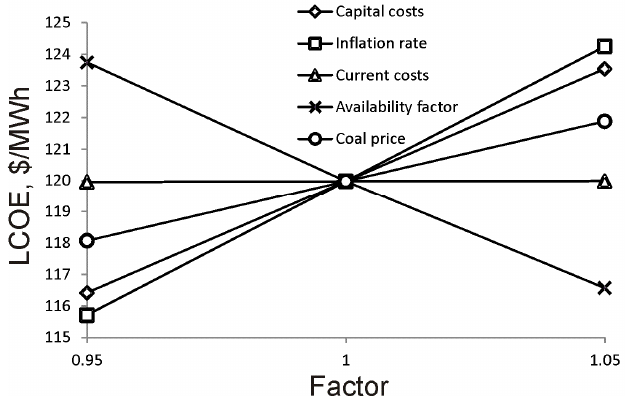
Figure 7. Sensitivity analysis of a two-stage gasifier-based IGCC.